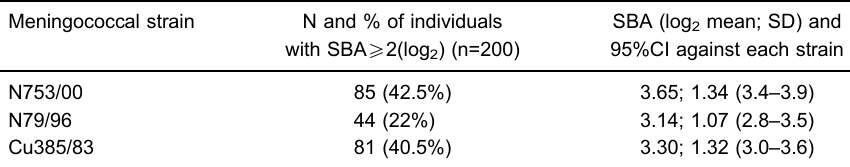
Table 1. Number (N) and percentage of individuals with protective serum bactericidal antibody (SBA) titers against meningococcal strains.